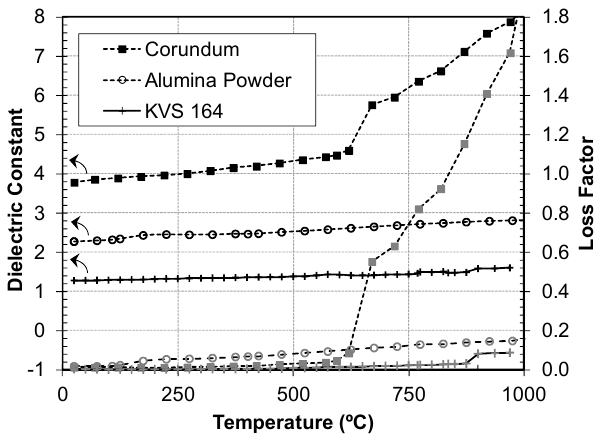
Figure 3. Dielectric properties of low loss materials at microwave frequencies during the heating process up to 1000 °C.